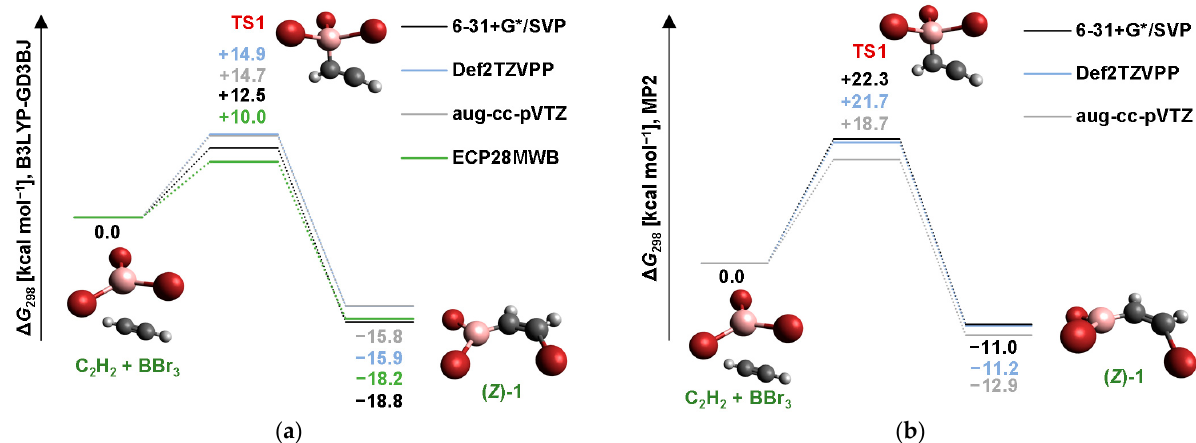
Molecules 2021 , 26 , x 3 of